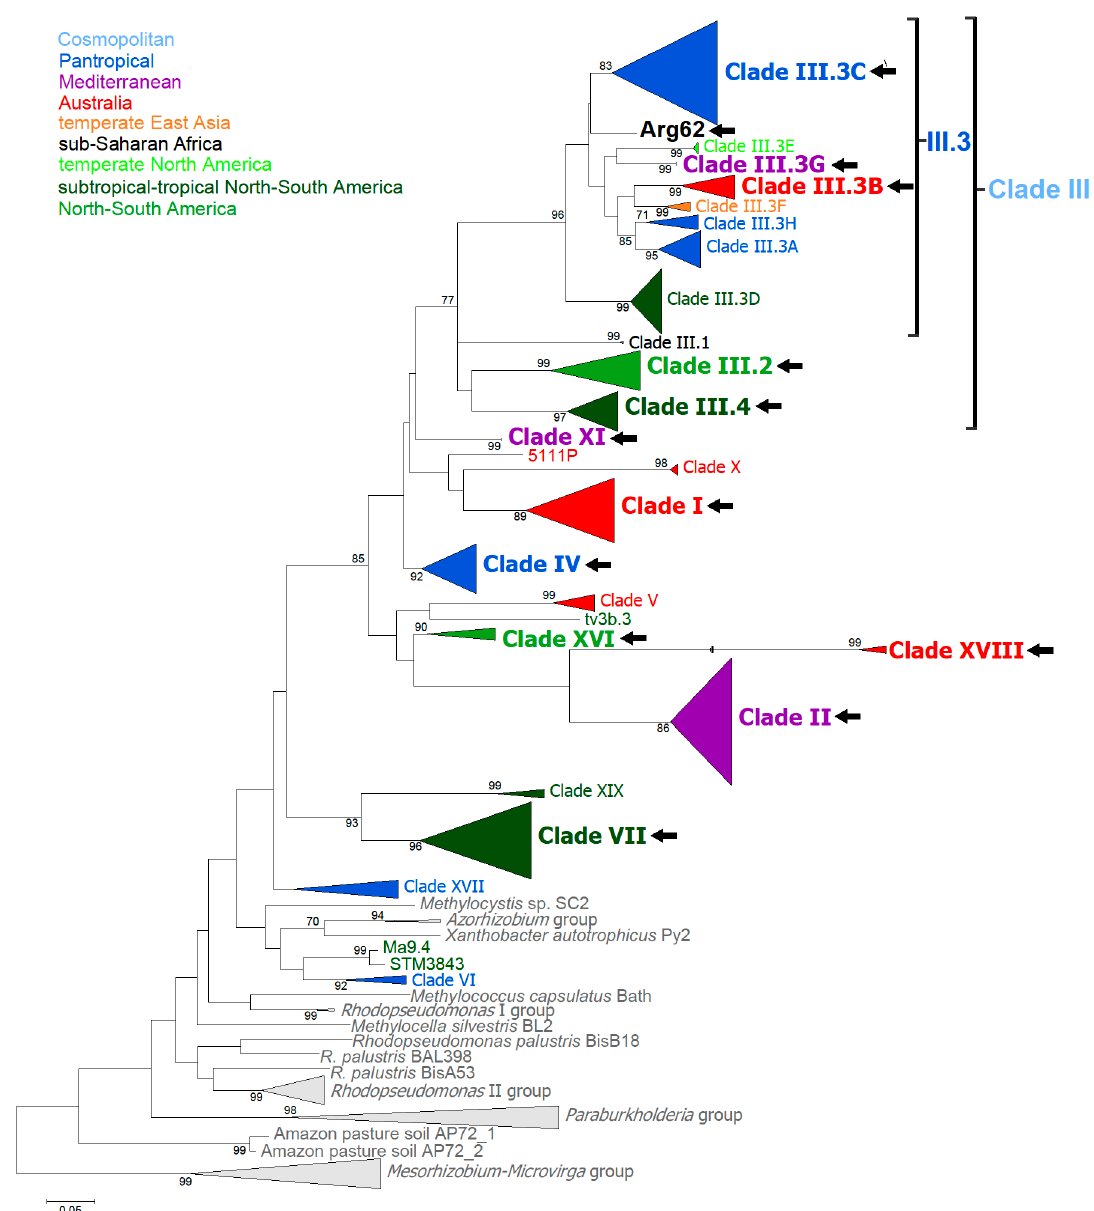
Figure 3. Maximum likelihood (ML) tree based on bradyrhizobial nifD gene sequences (759 bp). The significance of each branch is indicated by the bootstrap percentage calculated for 500 bootstraps. The bootstrap values greater than 70% are indicated at nodes. The sequences were aligned using ClustalW software and ML phylogenies were inferred with Mega 6 [17] using the best-fit